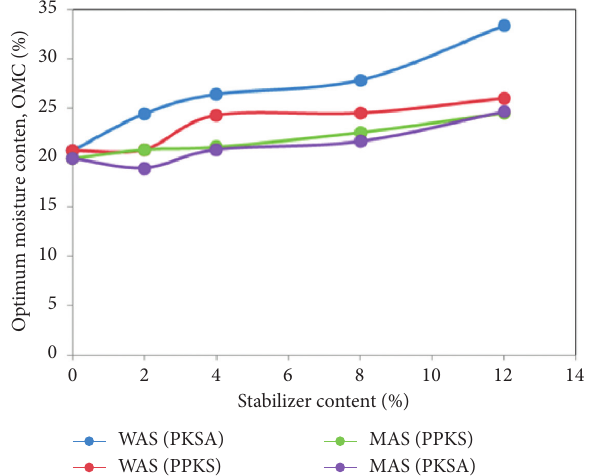
Figure 7: Optimum moisture content (OMC) versus PKSA and PPKS for the treated shale at MAS and WAS